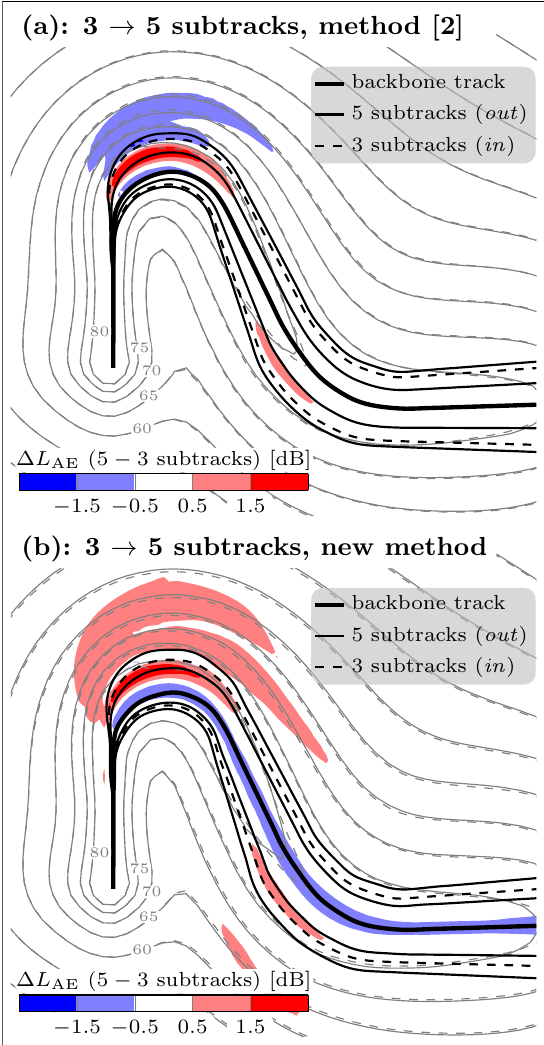
Figure 3: Differences in the resulting L AE on the receiver grid be- tween the calculation using (a) normal and box distributions, and (b) box and normal distributions, with 5 subtracks in all cases, assuming the movement percentages from Table 1, for an A320 aircraft.